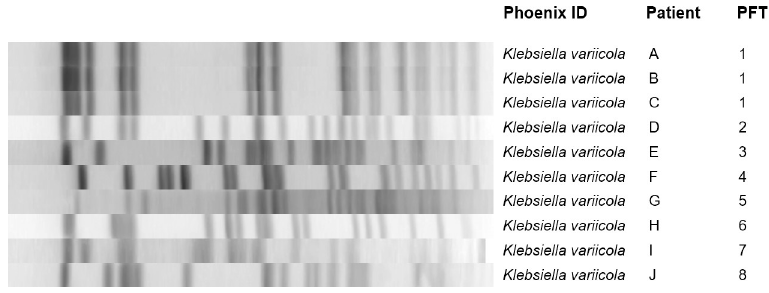
Fig 1. Pulsed-field gel electrophoresis analysis of 10 K . variicola isolates collected from wounded military